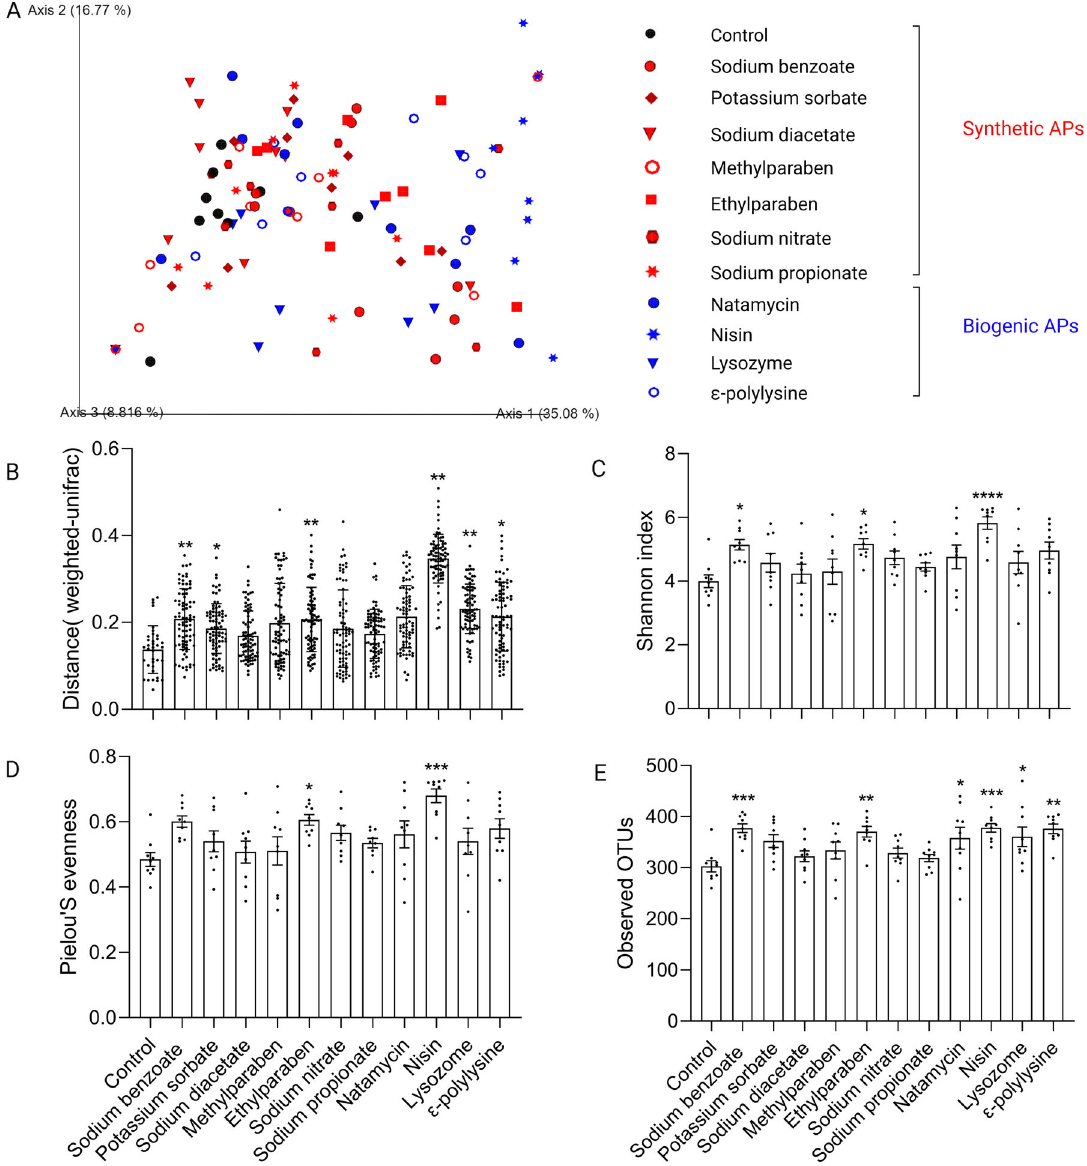
Fig. 2 Impact of APs on gut microbiota diversity. A PCoA of the Weighted UniFrac distance matrix of fecal microbiota. B Weighted UniFrac distances between APs-treated and control microbiota was plotted and compared to the distances within control samples. Signi fi cance was determined by PERMANOVA. FDR * P < 0.05, ** P < 0.01. C – E Alpha diversity analysis of gut microbiota between control and APs-treated groups measured with Shannon index ( C ), Pielou ’ s evenness index ( D ), and the number of observed OTUs ( E ). Signi fi cance was determined by ANOVA with Dunnett ’ s multiple comparisons test. The values are expressed as the means ± S.E.M., n = 9 per group. * P < 0.05, ** P < 0.01, *** P < 0.001, **** P <